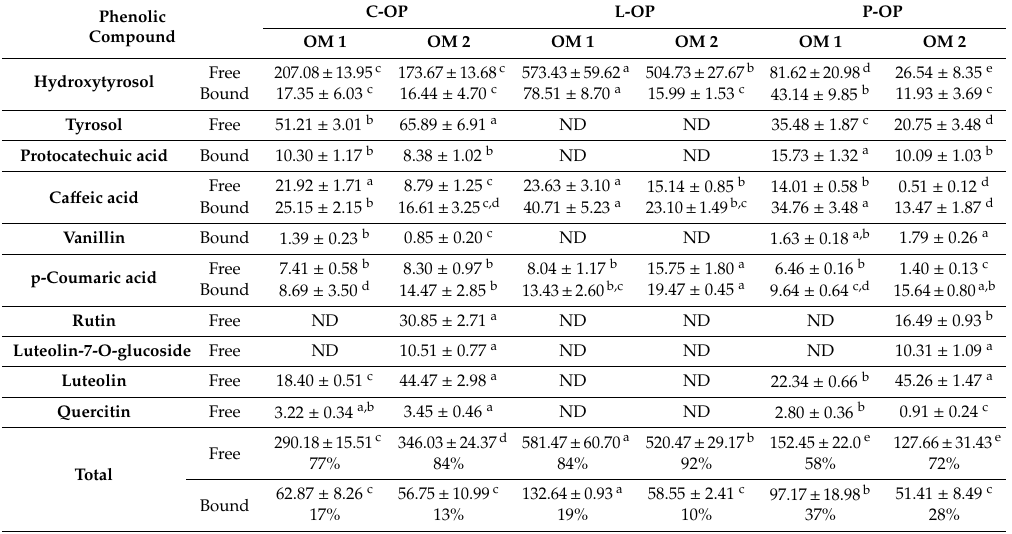
Table 3. Phenolic composition (mg / 100 g DW) in crude olive pomace (C-OP), a liquid-rich fraction (L-OP) and pulp-rich fraction (P-OP) from olive pomace.